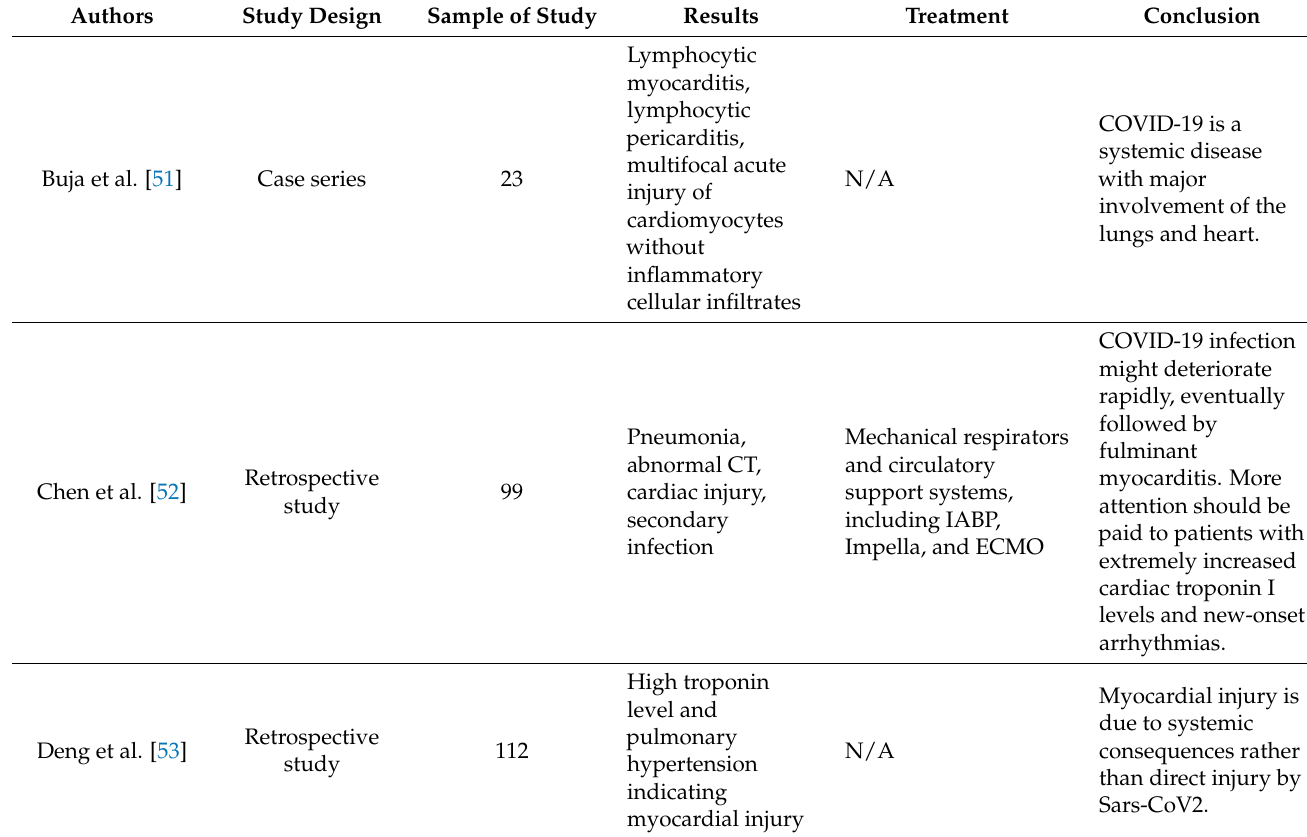
Table 2. The connection between myocardial injury and COVID-19 as discussed in the relevant